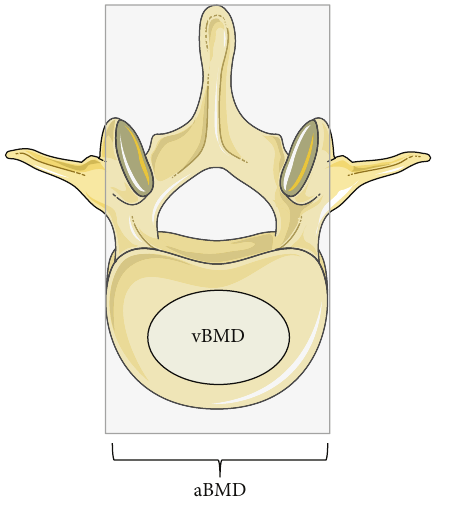
Figure5:Regionsofthelumbarspinevertebraincludedinmeasure- mentofbonemineraldensitybyDXAandQCTscans.Inadditionto the vertebral body, areal bone mineral density (aBMD) as assessed by DXA includes density measurement of the posterior processes (spinous process) as indicated by the background light gray square. Measurement of volumetric bone mineral density (vBMD) by QCT- scans includes only the central (trabecular) part of the vertebral